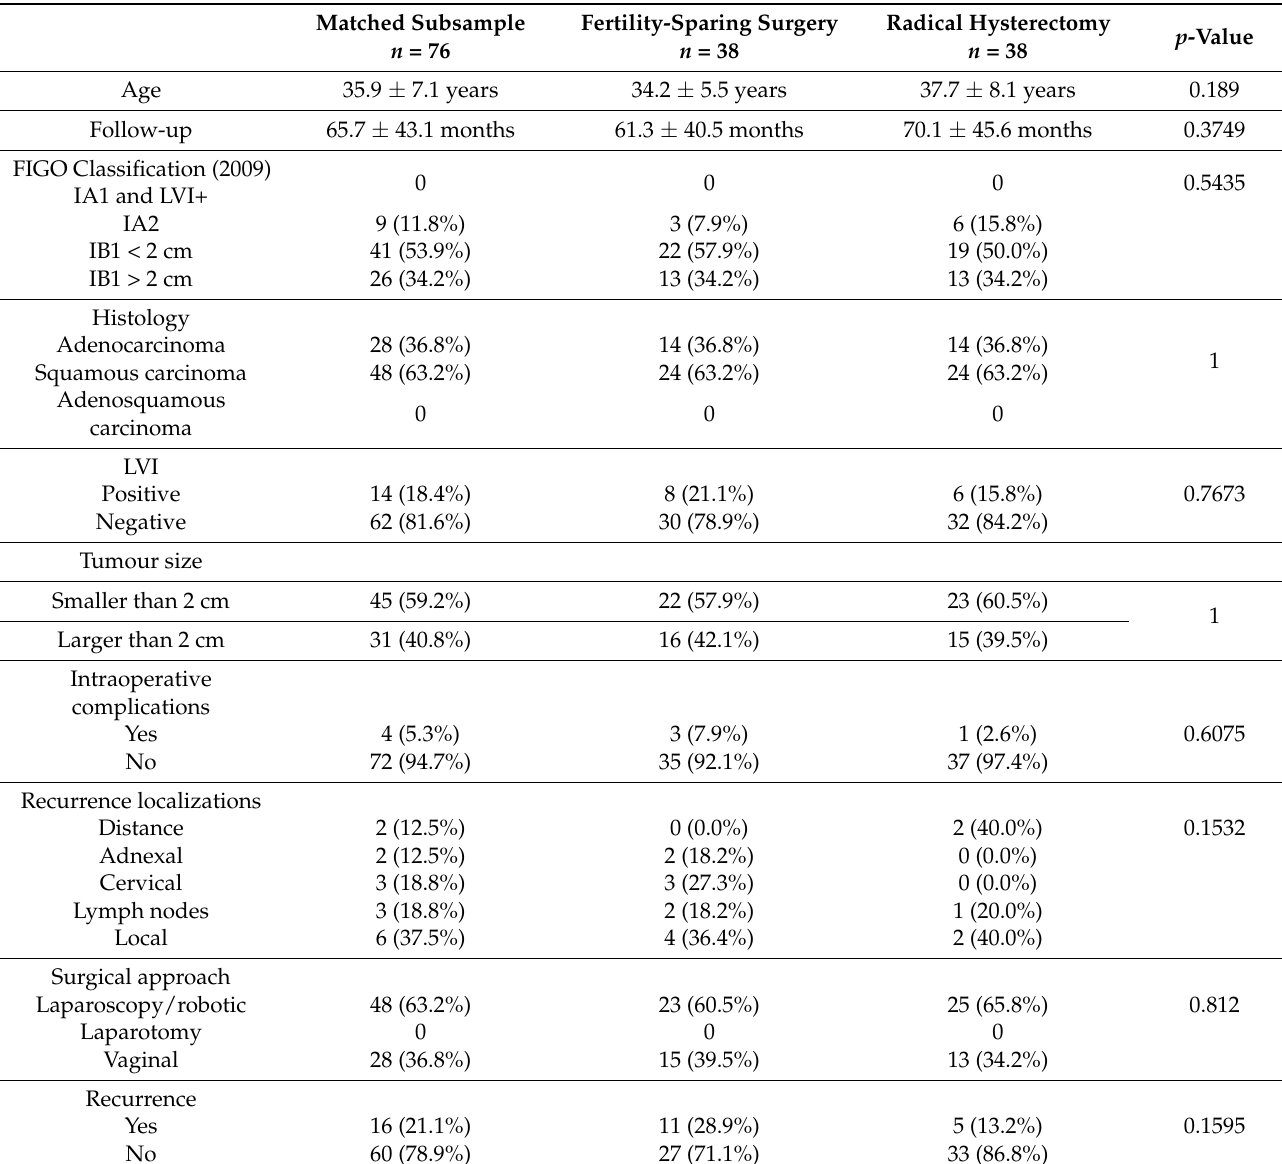
Table 3. Clinicopathological characteristics of the matched